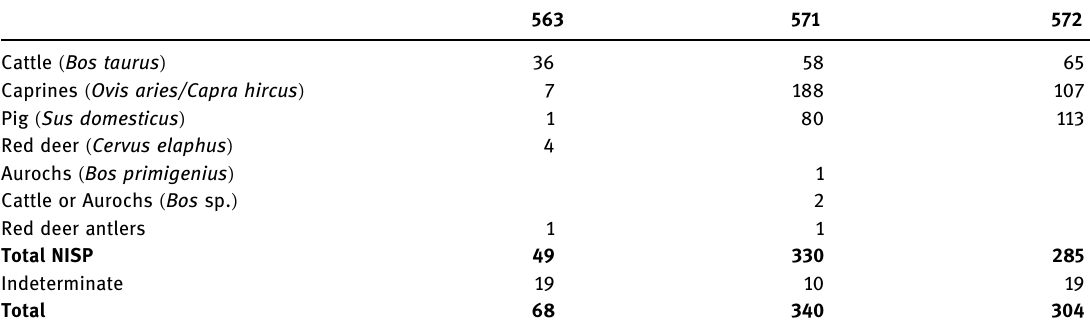
Table 2: List of faunal remains discovered in three ditch segments from the LBK enclosure of Menneville “ Derrière le Village ” : 563, 571, 572 ( excavations 2013 – 2016 )